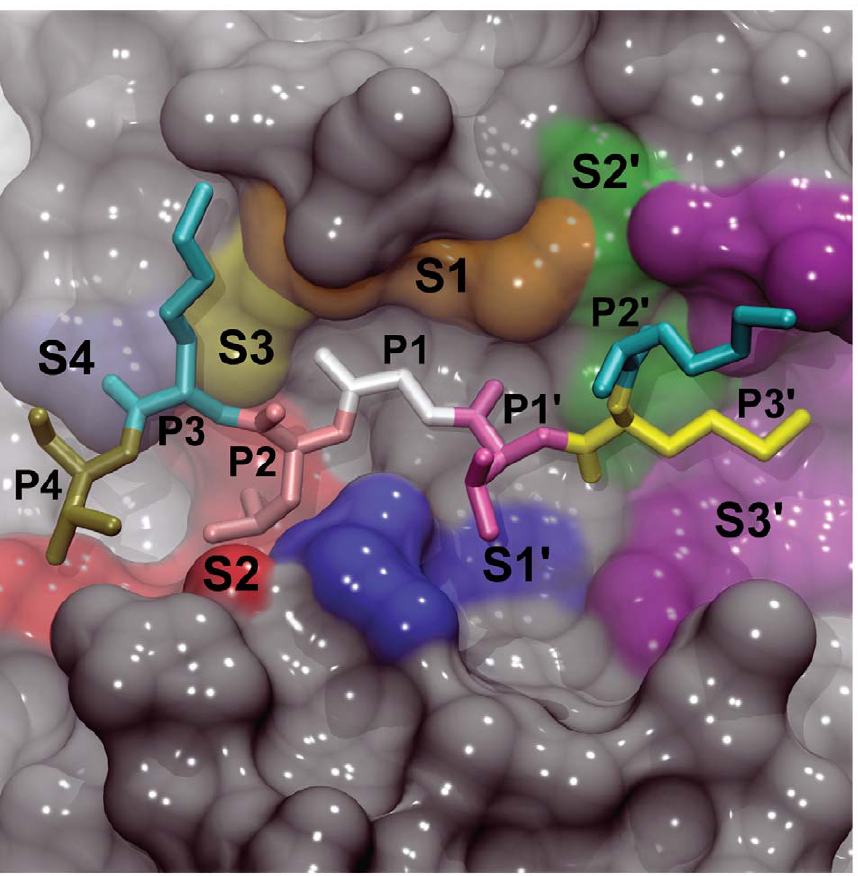
Figure 2. The cruzain active site colored according to the seven substrate-binding subsites. Four subsites on the acyl side of the cleaved peptide bond, named S4, S3, S2, and S1, bind the peptide amino acids P4, P3, P2, and P1. Three subsites on the amino side of the bond, named S1 9 , S2 9 , S3 9 , bind the peptide amino acids P1 9 , P2 9 , and P3 9 . As no crystal structure of cruzain bound to a peptide substrate was available, the peptide shown was taken from a crystal structure of the homologous protein procathepsin K (PDB: 1BY8).